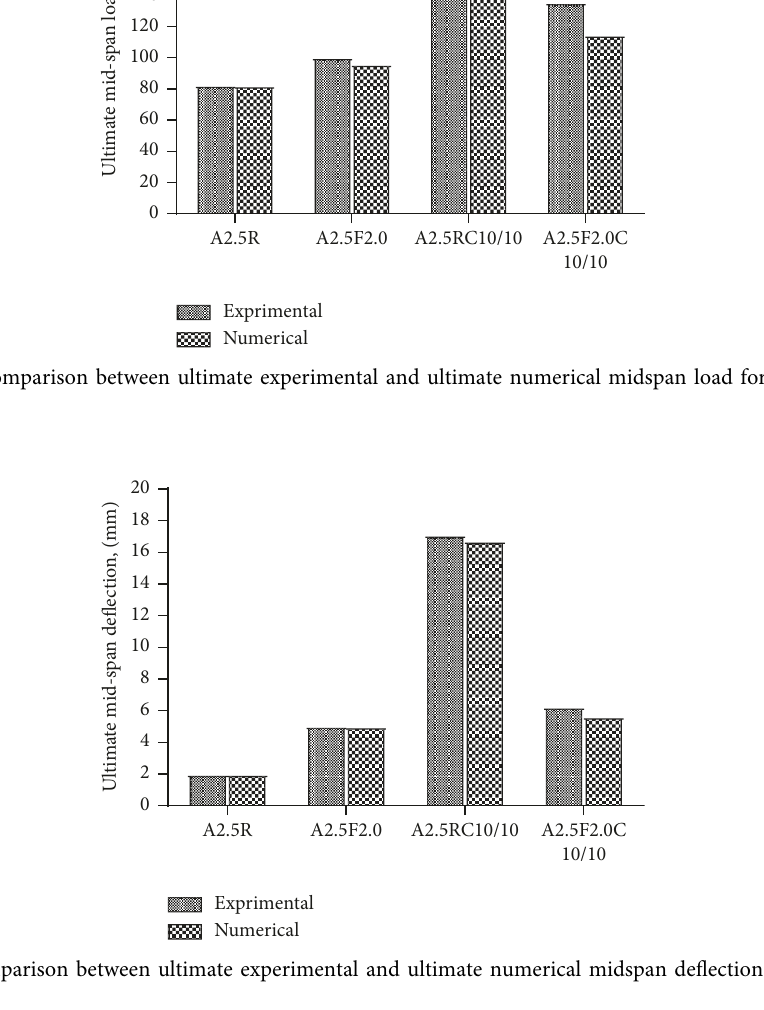
Table 7: The percentage change in failure load values obtained from the experimental approach and numerical simulation. Beam Change of failure load in the experiment (%) Change of failure load in the numerical (%) A2.5 R — — A2.5F2.0 17.66 14.32 A2.5RC10/10 53.70 A2.5F2.0C10/10